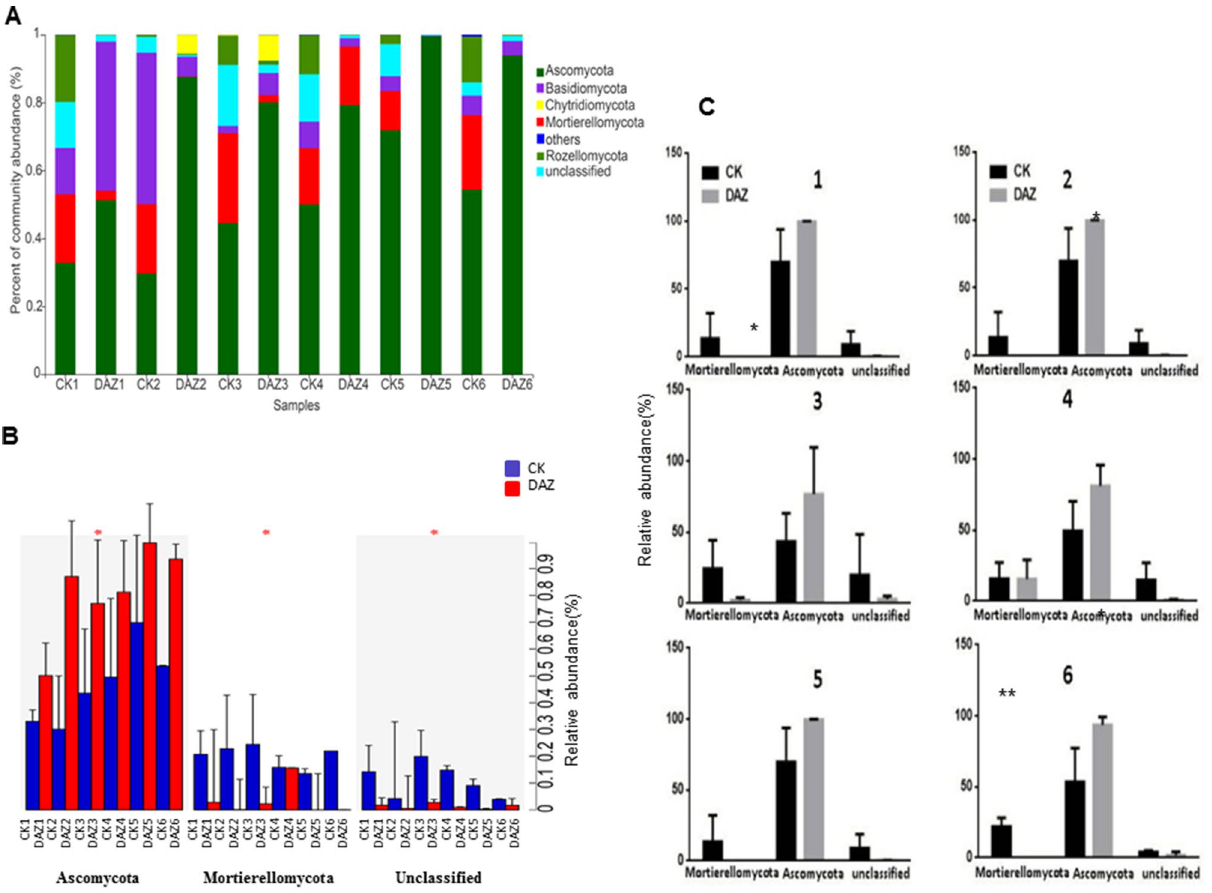
Figure 6. Dynamic changes of dominant fungal community analyses on phylum level. ( A ) Community bar plot analysis of soil fungal community abundance in different sampling times on phylum level. ( B ) Kruskal–Wallis H test was used to test the significance of the dynamic changes of fungal community relative abundance at different sampling times on phylum level. ( C ) Student’s t-test bar plot showed significant differences of the main fungal phyla between treatment and CK. The X-axis represents the bacterial phylum, the Y-axis represents its average relative abundance. DAZ dazomet treatment, CK control. Numbers after letters indicate different sampling times. 1 (March 6th, 2018, before dazomet treatment), 2 (April 24th, 2018, watermelon seedling stage), 3 (May 3rd, 2018, Fusarium wilt symptom appearance), 4 (March 6th, 2019, before dazomet treatment), 5 (April